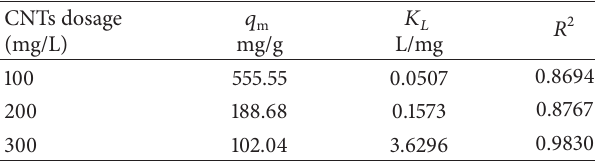
Table 4: Adsorption isotherm constants of Langmuir model for basic orange dye (pH = 8.5 and contact time = 30 min).